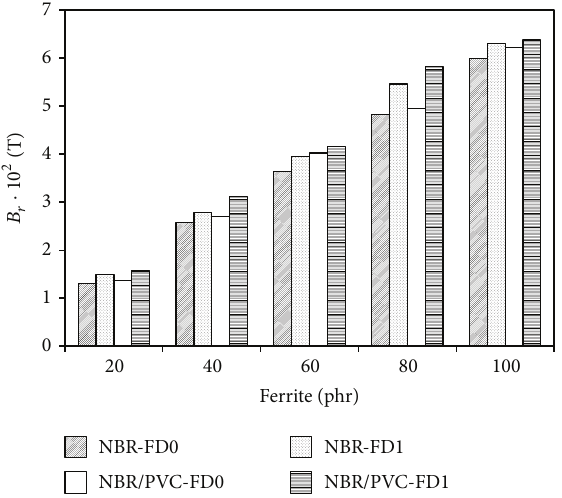
Figure 14: Influence of ferrites content on remanent magnetic induction 𝐵 𝑟 of composites.